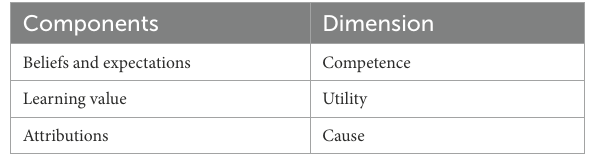
TABLE 1 Motivation